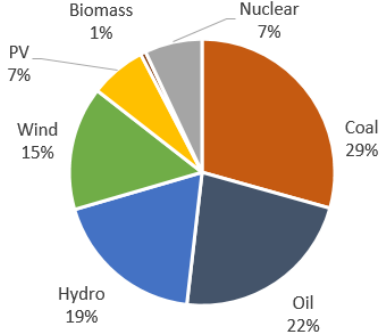
Figure 1. Installed power ( Pi ) of different primary sources in Romania as of November 2017.